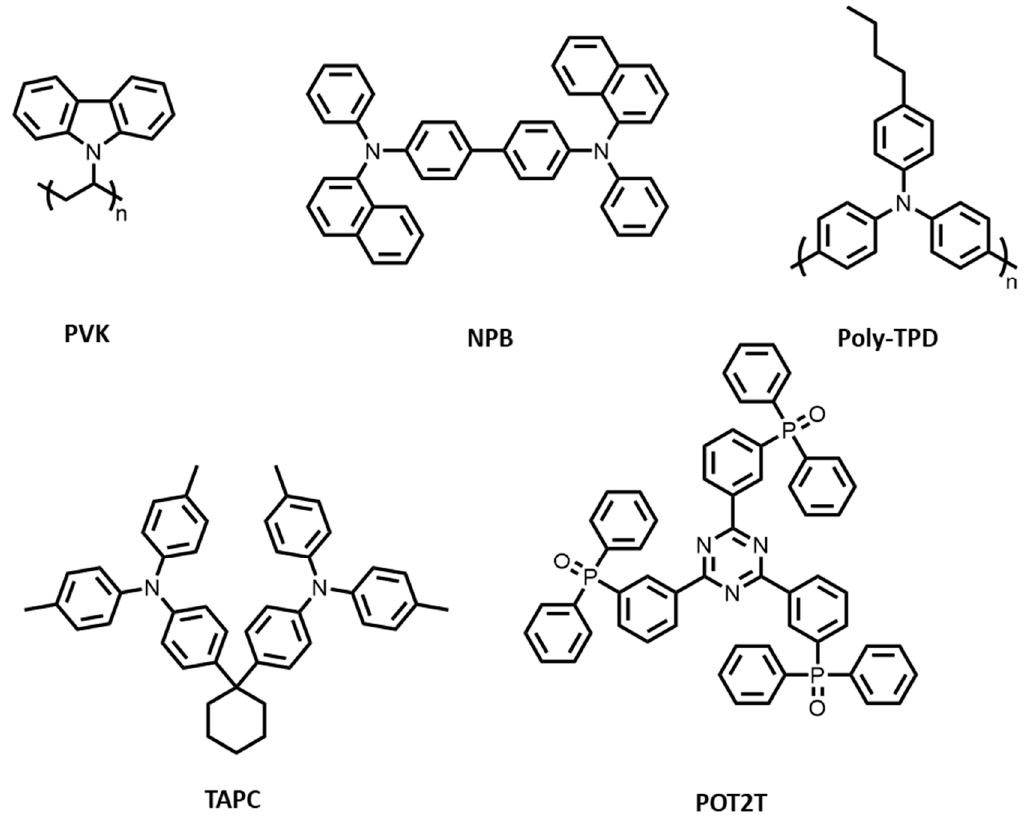
Figure 1. Chemical structures of donor and acceptor materials used in this work. 4,4 ′ -cyclohexylidenebis[N,N-bis(4- methylphenyl)benzenamine (TAPC), poly(9-vinylcarbazole) (PVK), N,N ′ -Di(1-naphthyl)-N,N ′ -diphenyl-(1,1 ′ -biphenyl)- 4,4 ′ -diamine (NPB), and poly(N,N'-bis-4-butylphenyl-N,N'-bisphenyl)benzidine (Poly-TPD) are used as the donors. 2,4,6- tris[3-(diphenylphosphinyl)phenyl]-1,3,5-triazine (POT2T) is used as the acceptor.